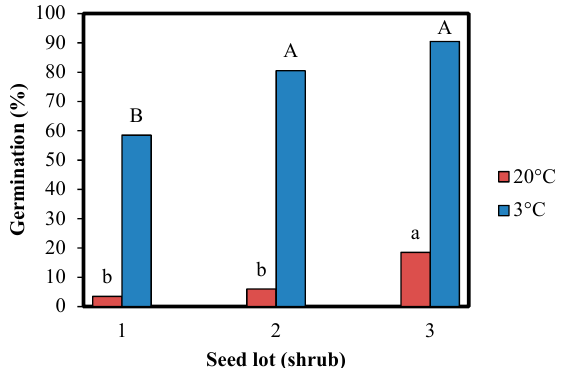
Figure 1. Effect of temperature on Rosa canina L. seed germination after dormancy breaking by warm/cold stratification (16 weeks at 25 °C followed by 22 weeks at 3 °C). Germination tests were performed for 8 weeks at 3 and 20 °C. Seeds were collected from three different shrubs (1–3). Data with different letters (lowercase for 20 °C and capital for 3 °C) are significantly different, p < 0.05 (ANOVA and a Tukey–Kramer HSD).